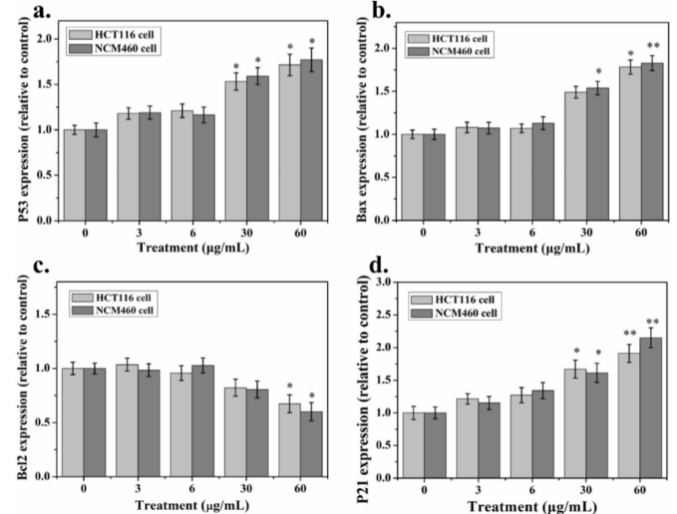
Figure 4. RT-PCR Analysis of the Expression Changes in mRNA Level of P53, Bax, Bcl-2, P21 after exposure to Ag NPs for HCT116 and NCM460 cells. The experiment was in triplicate and data represent mean. * means p < 0.05; ** means p <